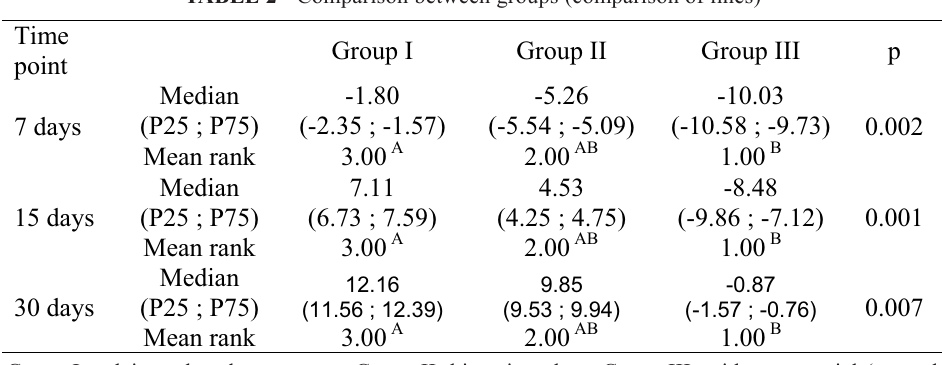
TABLE 2 - Comparison between groups (comparison of